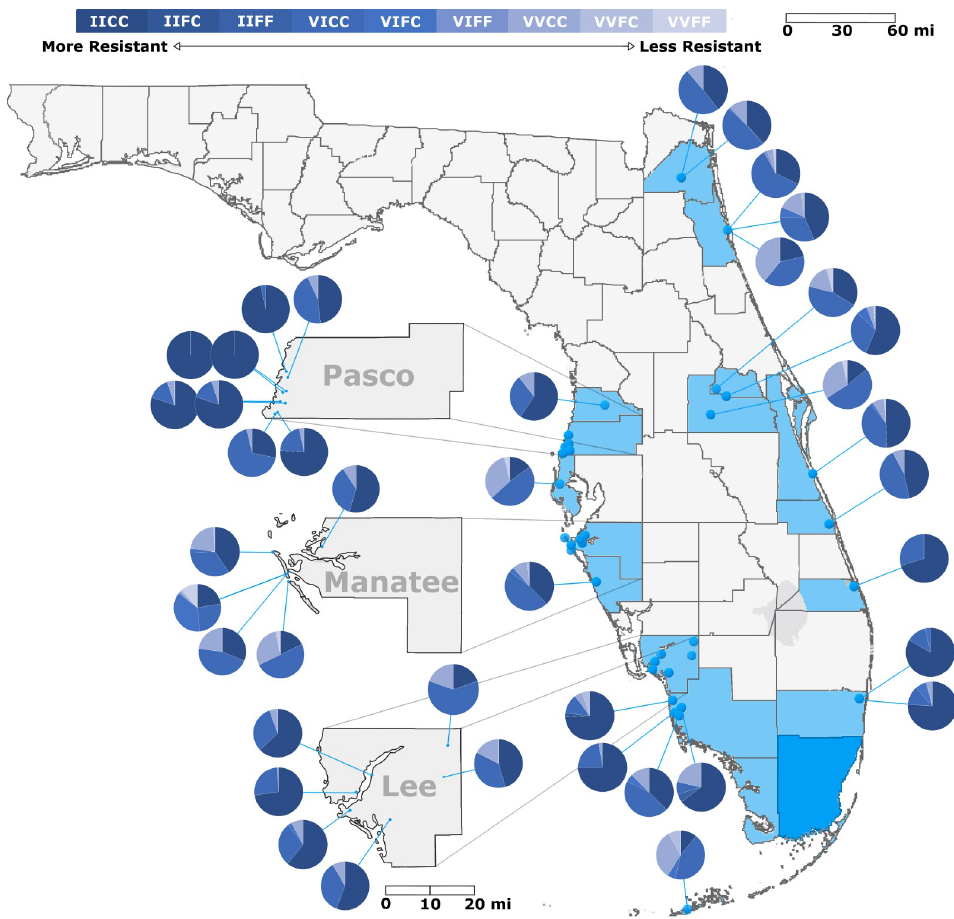
Fig 2. Frequency of kdr genotypes in 40 strains of FL Aedes aegypti . Genotype frequencies were determined using the methods of [28, 29] as described in the methods section. Specific collection locations that are included in each tested population are noted in S1 File. Strains included a minimum of 25 individual organisms. Base maps were sourced from ESRI and Tele Atlas data through ArcGIS Online under an enterprise license with USDA. Additional layers were added to the base map using GIMP 2.8. Graphical representation of kdr frequencies was produced using Microsoft Excel and included as an additional layer.